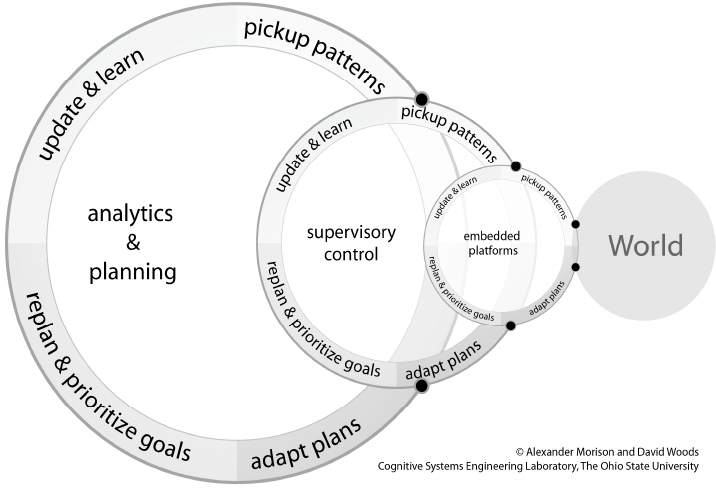
Figure 2. A general schematic of a human–computation–sensor system.